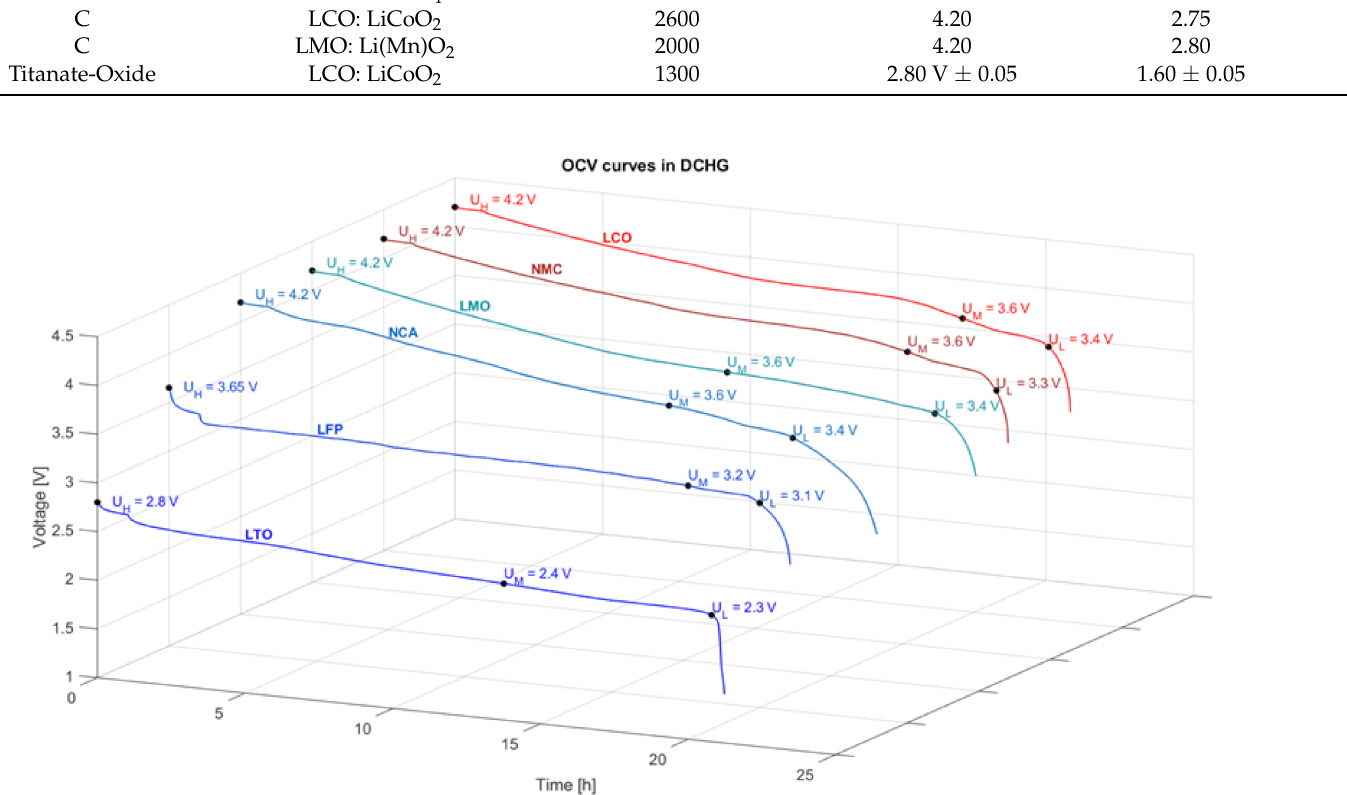
Figure 1. OCV curves of all six cell types, marked with all three storage voltages, respectively (U L -voltage low, U M -voltage mid, U H -voltage high), discharged with C/20 and an initial one-hour rest time in the